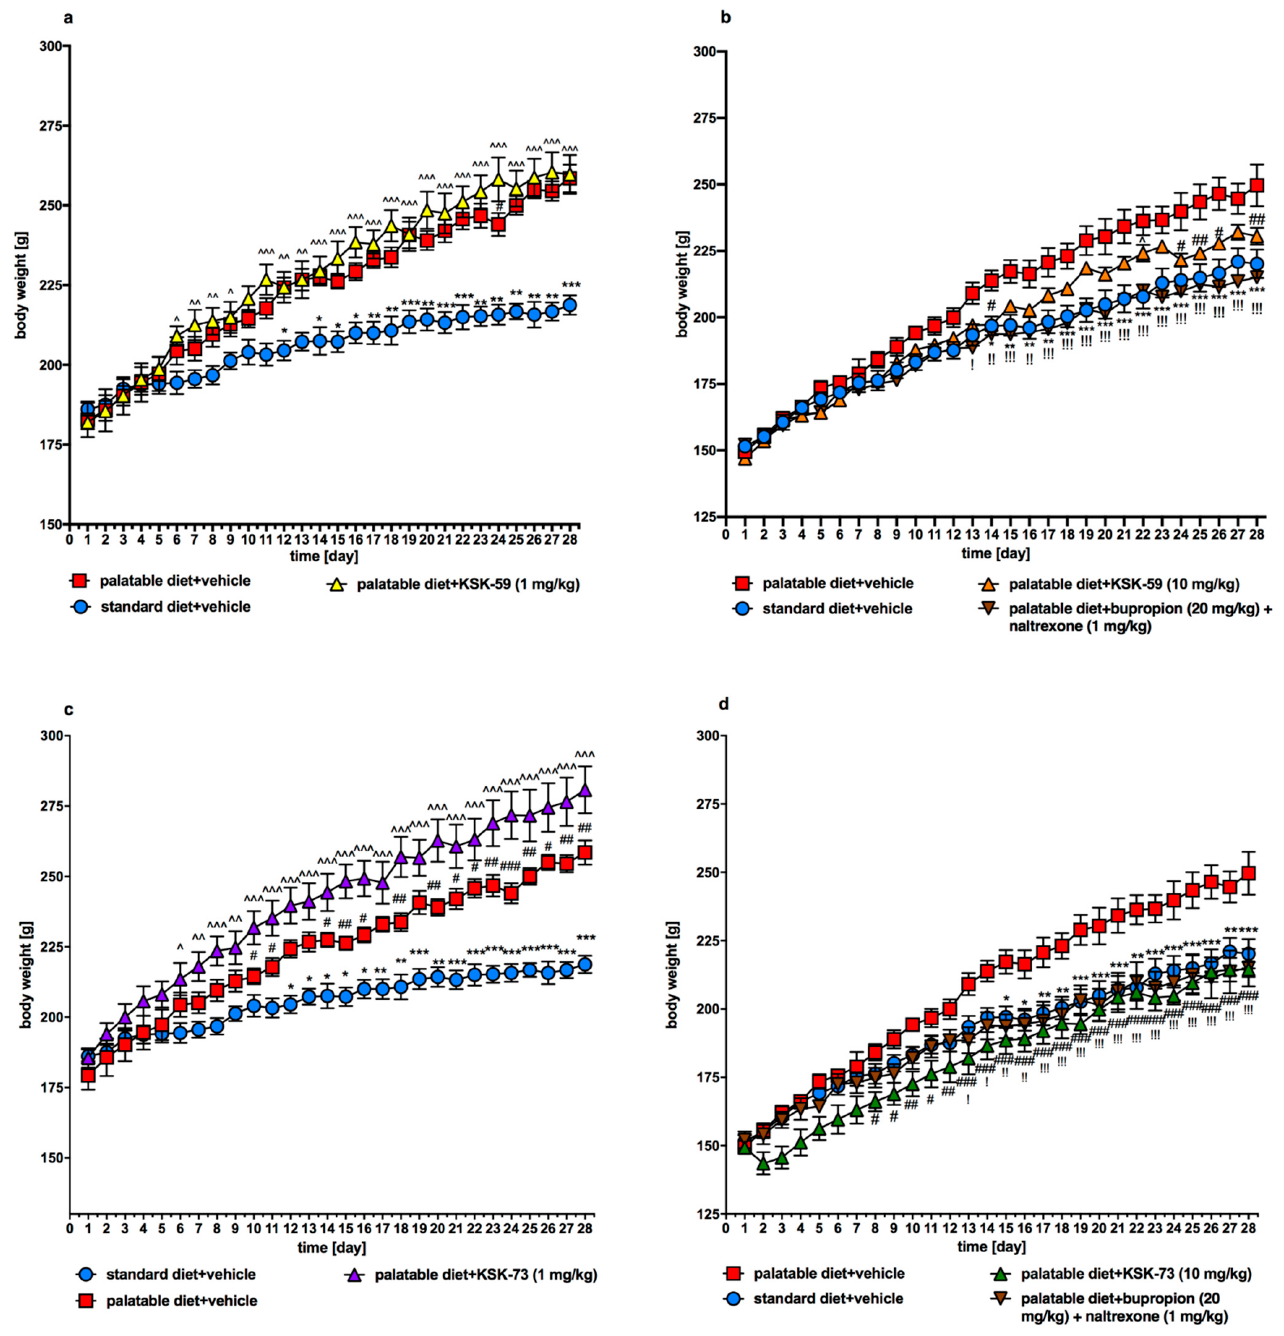
Figure 2. Body weight throughout the administration of the tested compounds or bupropion/naltrexone. ( a ) KSK-59 (1 mg/kg), ( b ) KSK-59 (10 mg/kg) and bupropion/naltrexone (10/1 mg/kg), ( c ) KSK-73 (1 mg/kg), ( d ) KSK-73 (10 mg/kg) and bupropion/naltrexone (10/1 mg/kg). Results are expressed as means ± SEM, n = 6. Multiple comparisons were performed by two-way ANOVA, Tukey’s post-hoc tests. * Significant against control group fed standard diet vs. control group fed palatable diet; ^ significant against tested compound administered group vs. control group fed standard diet; # significant against tested compound or bupropion/naltrexone administered group vs. control group fed palatable diet; ! significant against bupropion/naltrexone administered group vs. control group fed palatable diet; *, ^, #, ! p < 0.05, **, ^^, ##, !! p < 0.01, ***, ^^^, ###, !!! p < 0.001.